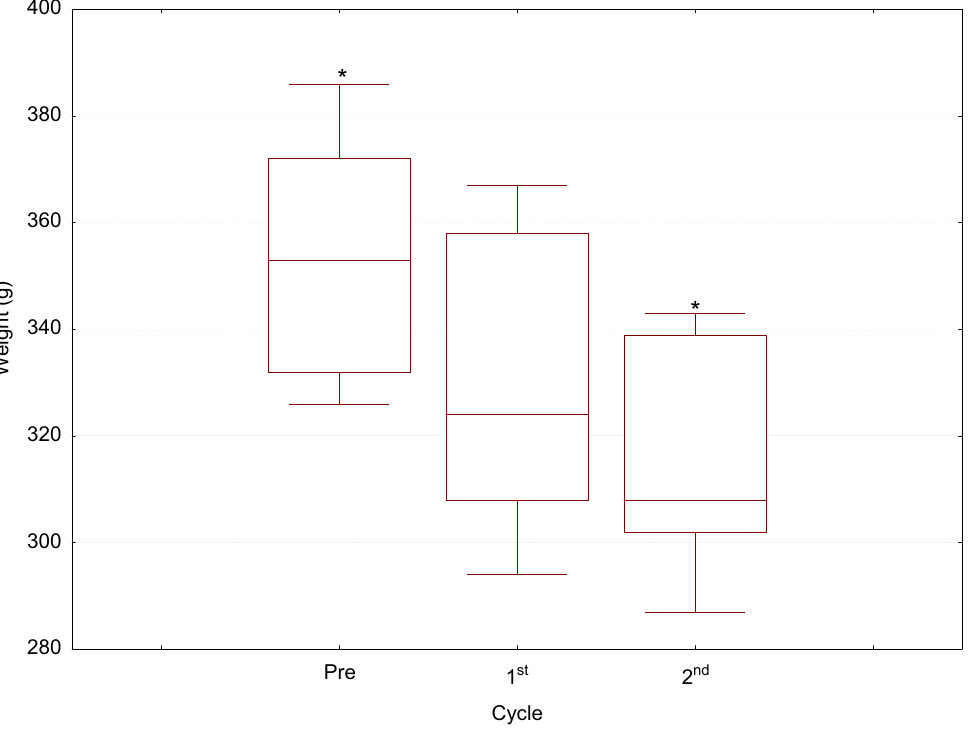
FIGURE 1 – The evolution of rats weight comparing pretreatment and after the first (1 st ) and second (2 nd ) post-docetaxel